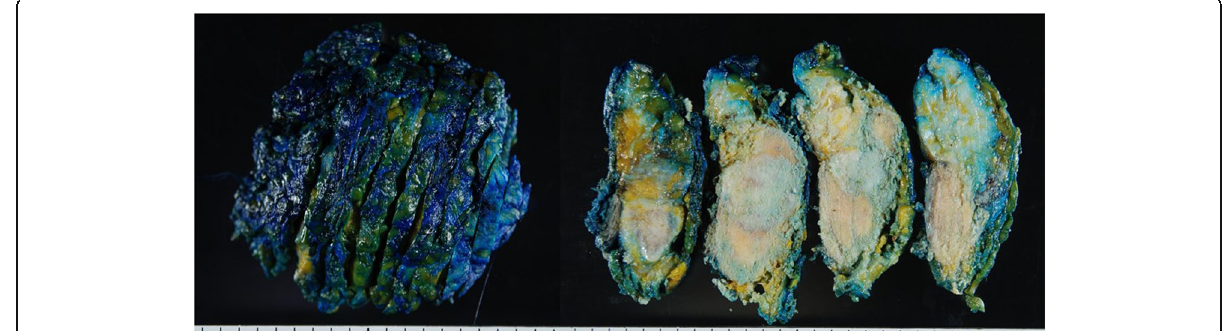
Fig. 4 Excised specimen. The center of the tumor is whitish, and both lateral portions are